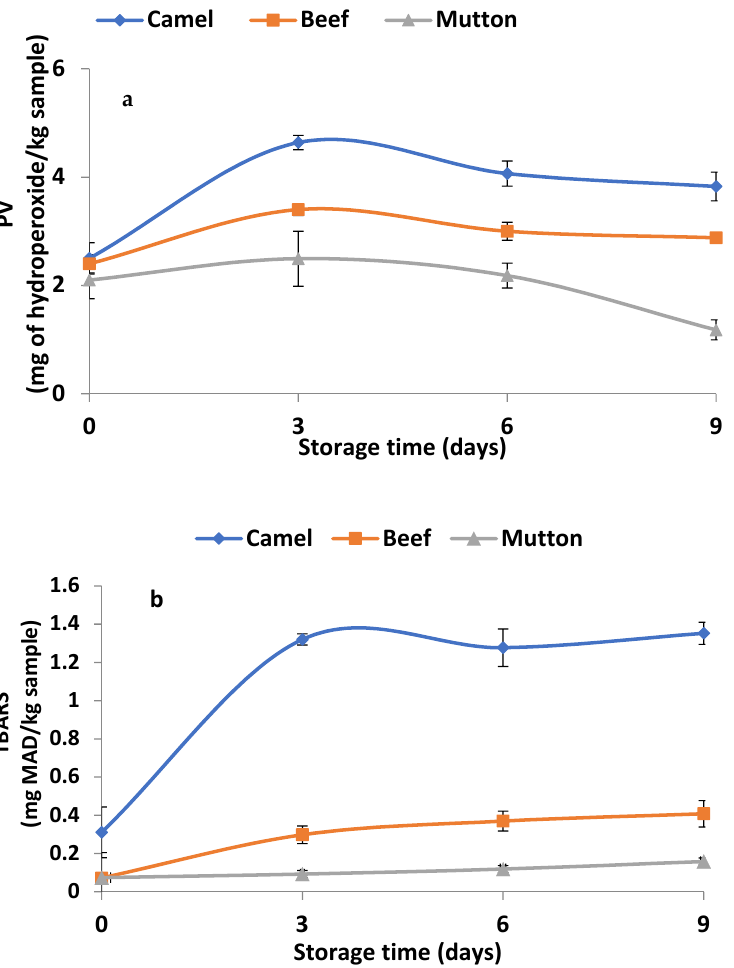
Figure 3. Changes in lipid oxidation products (peroxide value ( a ) and TBARS ( b )) in camel meat, beef and mutton during 9 days of refrigerated storage. Data are represented as mean ± SEM ( n = 6). 3.7. Changes in Total Pigment, Haemoglobin and Myoglobin Fresh camel meat had a higher total haem content (67.32 µg haematin/g of sample) than beef (60.38 µg haematin/g of sample) or mutton (40.25 µg haematin/g of sample) (Figure 4a). The total haem content in camel meat and that in beef significantly ( p < 0.05) decreased during the first 3 days of storage, and thereafter, the values were similar as storage progressed ( p > 0.05). The fresh camel meat and beef samples had similar haemo- globin contents ( p > 0.05), and the values were significantly higher ( p < 0.05) than that of fresh mutton (Figure 4b). However, the fresh beef and fresh mutton had lower myoglobin contents than camel meat (Figure 4c) ( p < 0.05). The haemoglobin contents in the meat samples started to decrease from day 3 of storage, with a sharp decrease observed in beef and mutton ( p < 0.05). However, a gradual decrease in the myoglobin contents as the stor- age period increased until day 9 was noticed in all the meat samples. The total haem value plays a significant role in the colour of fresh meat (Figure 5).